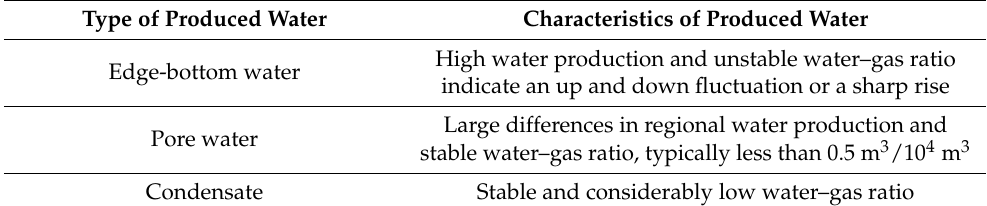
Table 4. Characterization of water produced in the gas